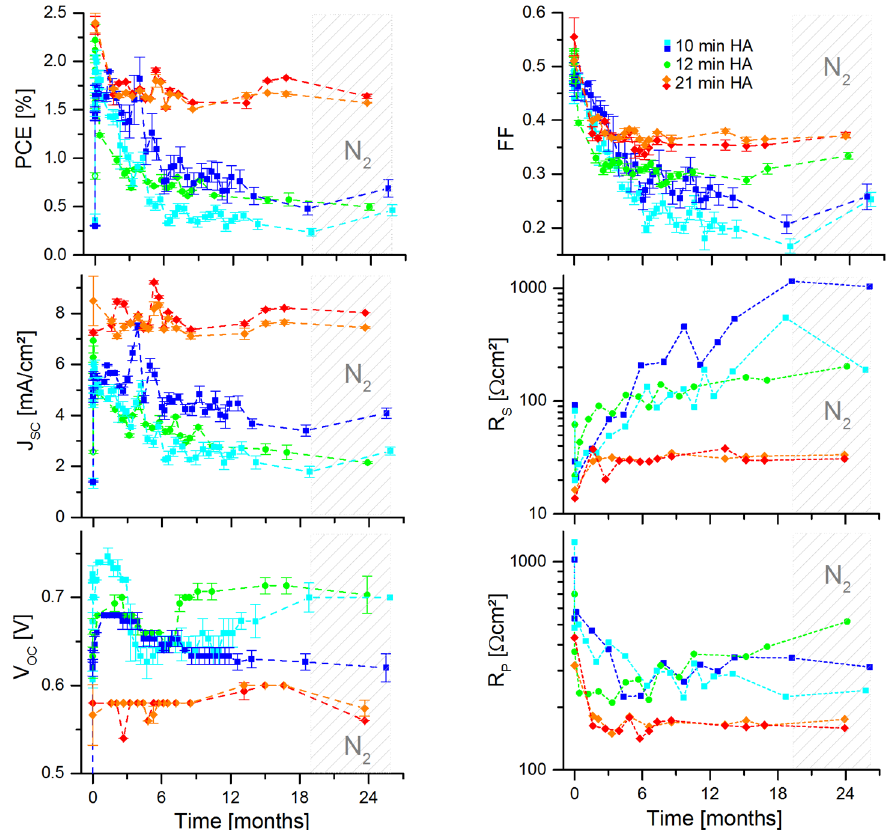
Figure 9. Parameters of PCPDTBT:CdSe QD solar cells from QDs washed by HA for 10 min (turquoise & blue squares), 12 min (green spherical points), and 21 min (orange & red rhombic points), stored in the dark inside a glovebox and periodically illuminated by a sun-simulator (AM 1.5 G spectrum) and characterized inside the same glovebox.